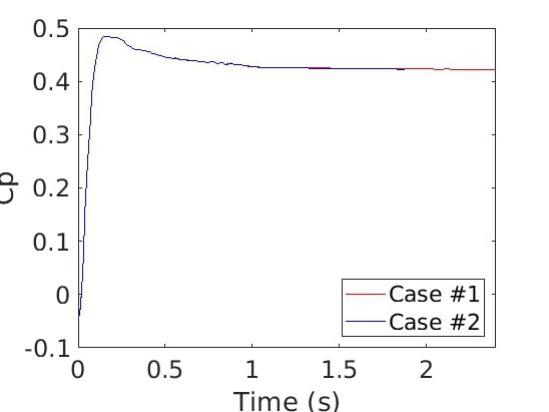
Figure 16. Time evolution of the power coefficient (Cp) with coarse (red line) and fine (blue line) mesh refinement in the